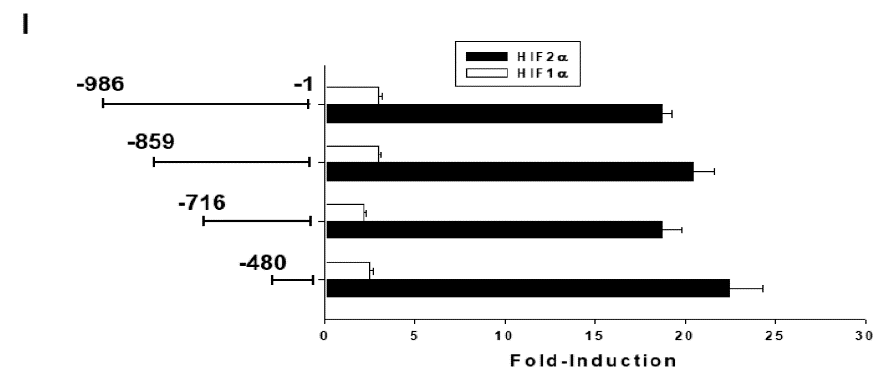
Figure 1. Gene expression of metallothionein 3 ( MT3 ) in human bladder carcinoma cells is upregulated by arsenic and hypoxia. ( A ) Total RNA was extracted from each different bladder cell line for RT-qPCR; ( B ) T24 cells were treated with various concentrations of As 2 O 3 for 24 h. Cells were lysed and HO-1, MT3, N-myc downstream regulated gene 1 (NDRG1), and β -actin were determined by immunoblotting; ( C ) quantitative analysis was done by determining the intensity of each band of the target gene and β -actin from three independent experiments. Data are presented as the fold-induction of the relative density of the target gene/ β -actin ( ± SE, n = 3) in relation to the control solvent-treated group (* p < 0.05, ** p < 0.01); ( D ) T24 cells were treated with various concentrations of As 2 O 3